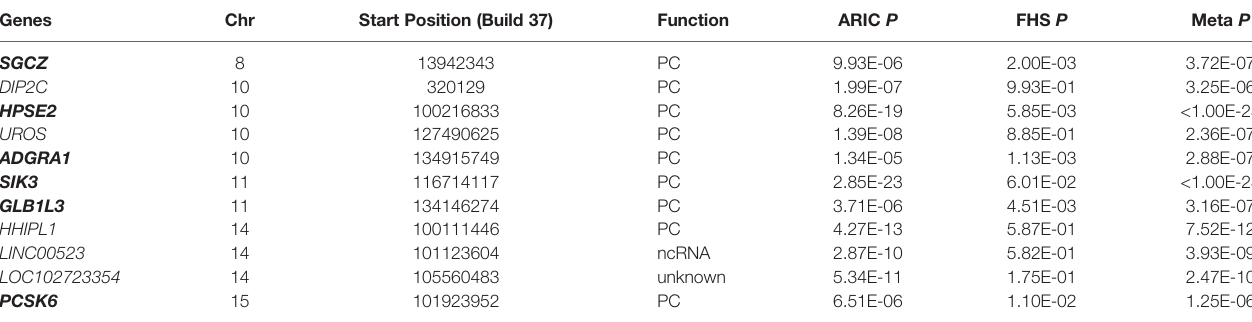
Chr, chromosome; PC, protein coding; ncRNA, non-coding RNA; ARIC, Atherosclerosis Risk in Communities Study; FHS, Framingham Heart Study. Bolded genes were successfully replicated in FHS and reached genome-wide signi fi cance level in the combined analyses.